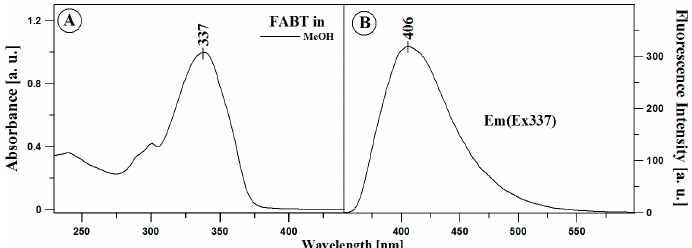
Figure 1. Panel ( A )—Normalized electronic absorption spectra for FABT (Panel ( A )) obtained in MeOH presented in the spectral range of 230–440 nm. Panel ( B ) presents fluorescence emission spectra of FABT recorded from MeOH. The emission spectra correspond to the measurements presented in Panel ( A ). The symbol Em(Ex337) stands for excitation emission spectra at 337 nm. The measurements were performed at the temperature of 22 °C.